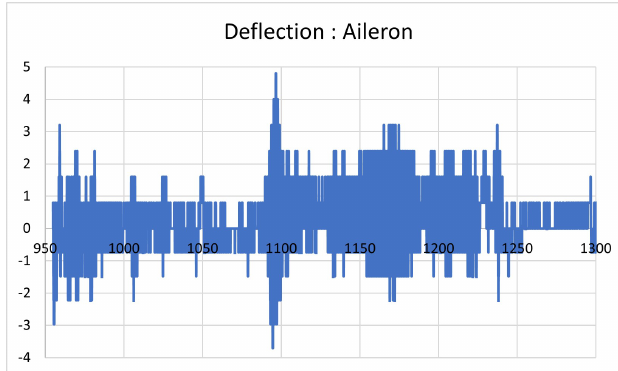
Figure 7. Aileron Deflection: Flight 2.